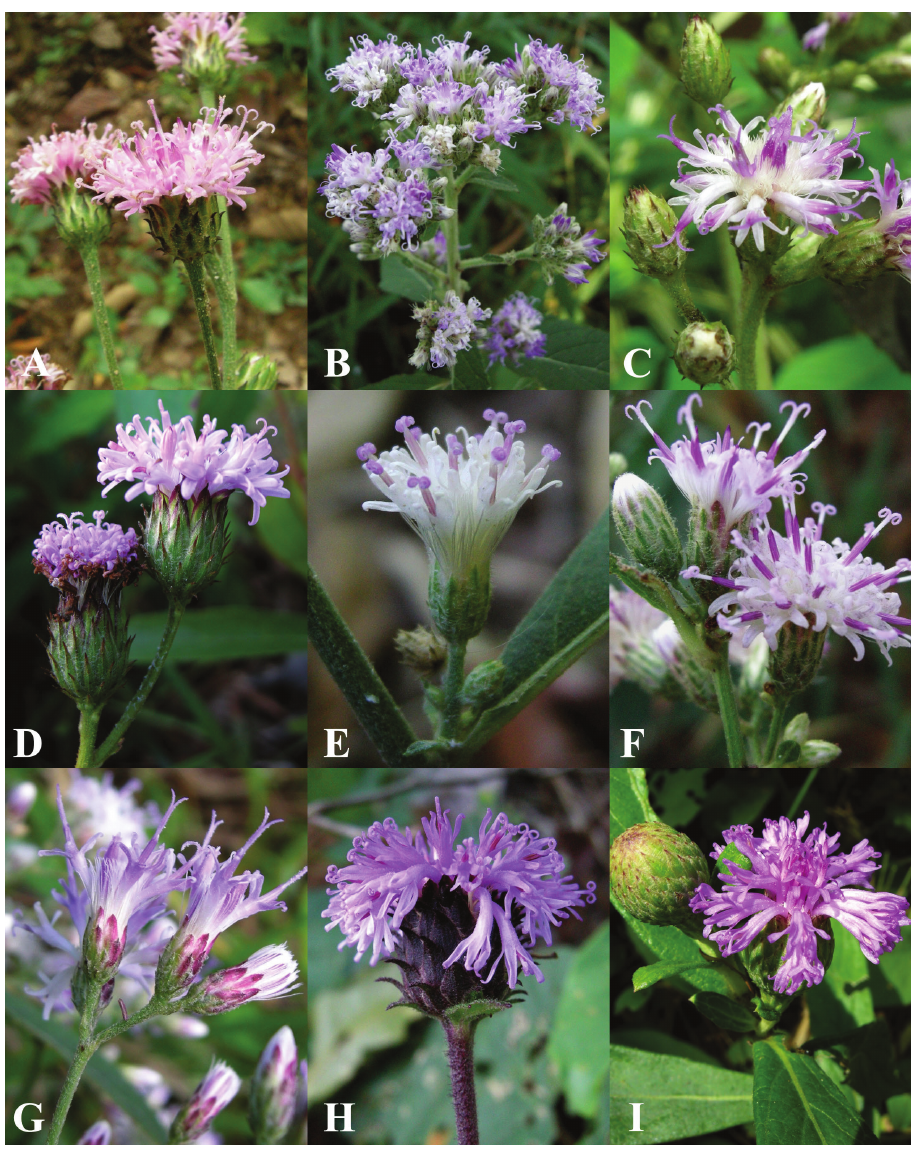
Figure 5. Morphology of Vernonieae in Thailand 1. A Acilepis attenuata B Acilepis divergens C Acilepis namnaoensis D Acilepis ngaoensis E Acilepis peguensis F Acilepis principis G Acilepis saligna H Acilepis sil- hetensis I Acilepis